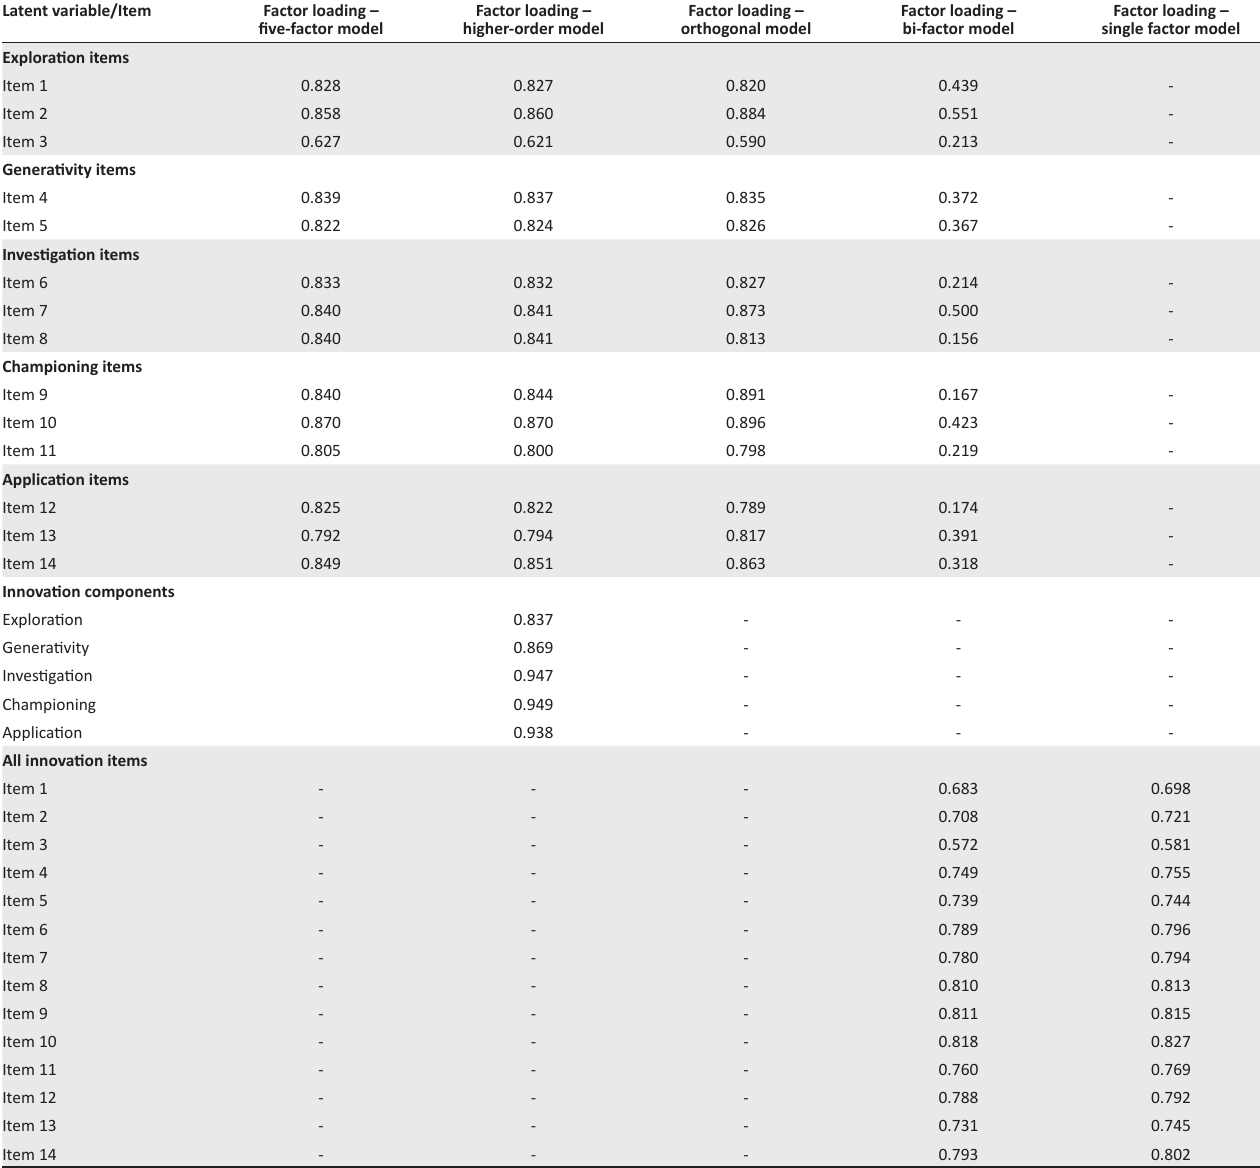
TABLE 5: Loading of the different items per